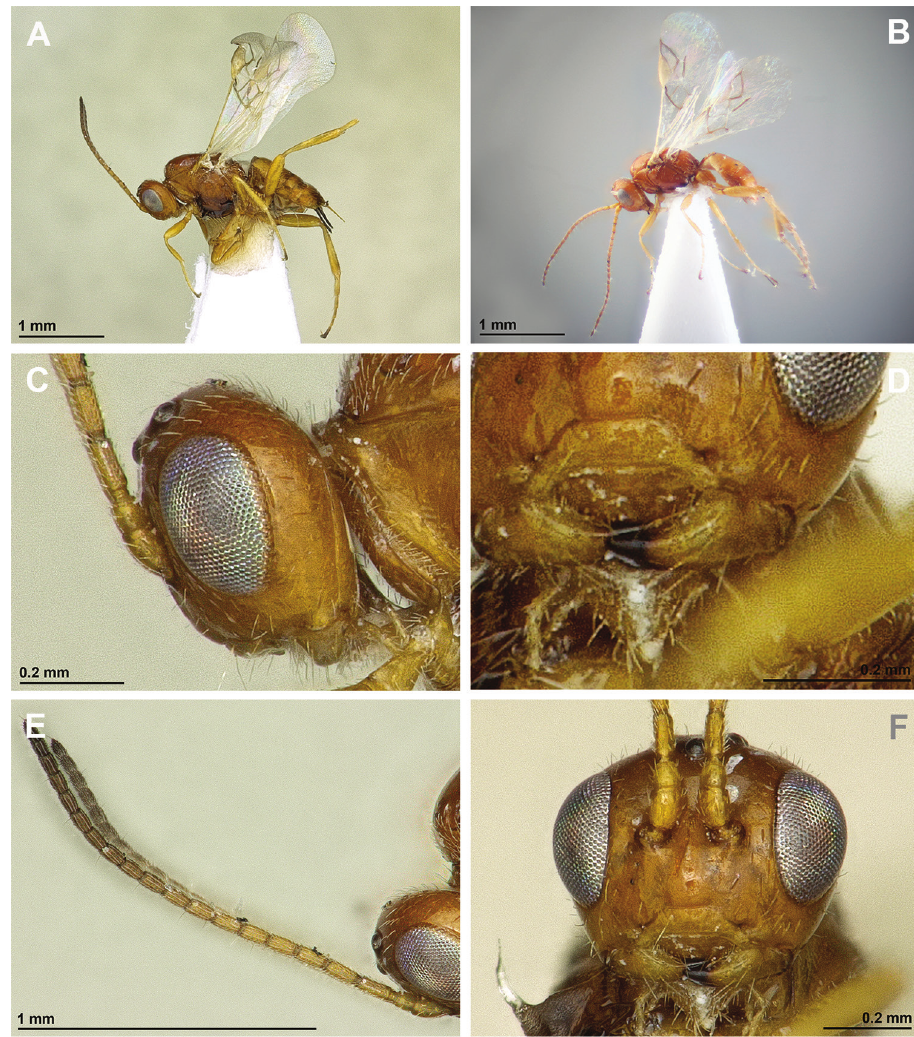
Figure 1. Hoplocrotaphus hamooniae sp. n. ( A, C–F female holotype B male paratype) A–B Habitus, lateral view C Head, lateral view D Mandible E Antenna F Head, frontal view. pterostigma broad. Vein 3-SR 0.8 times as long as vein 2-SR. Vein m-cu interstitial. Hind wing 3.9 times as long as its maximum